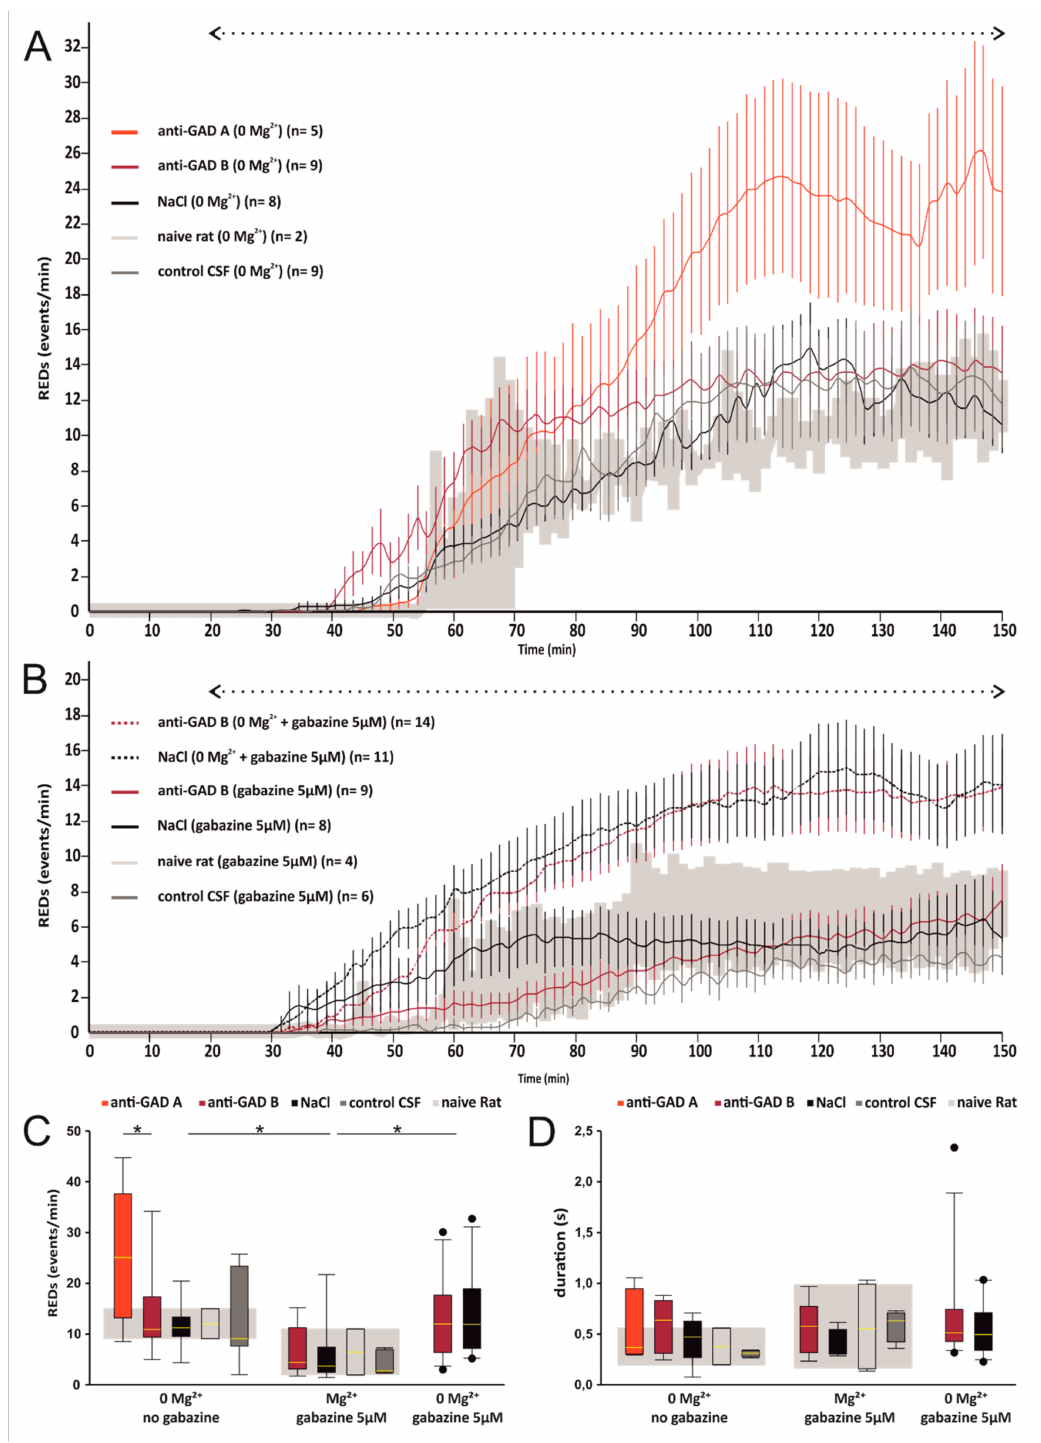
Figure 3. Average RED frequency and average duration. All slices showed no spontaneous activity at the beginning of each recording. Upon changing standard ACSF to the modified one, REDs occurred after 20–30 min ( A,B ). Average RED frequency for the last 10 min revealed no significant di ff erences between the anti-GAD-B-treated and corresponding control tissues, but slices in the Mg 2 + -free ACSF generally showed significant higher RED frequencies than the gabazine-treated slices (* in panel C ). Furthermore, in the Mg 2 + -free ASCF the anti-GAD-A had significantly higher RED frequencies than anti-GAD-B. Panel D shows the average duration of all REDs during the last 5 min of each recording, and again there were no significant di ff erences. The mean frequency and mean duration of naive slices are highlighted in (light) gray. An influence due to the surgical procedure is very unlikely. Outliers are plotted as black dots (panel C + D ). In Mg 2 + free and gabazine containing solution we found one slice treated with anti-GAD B that showed a higher average duration (t average = 2.33 s) compared to